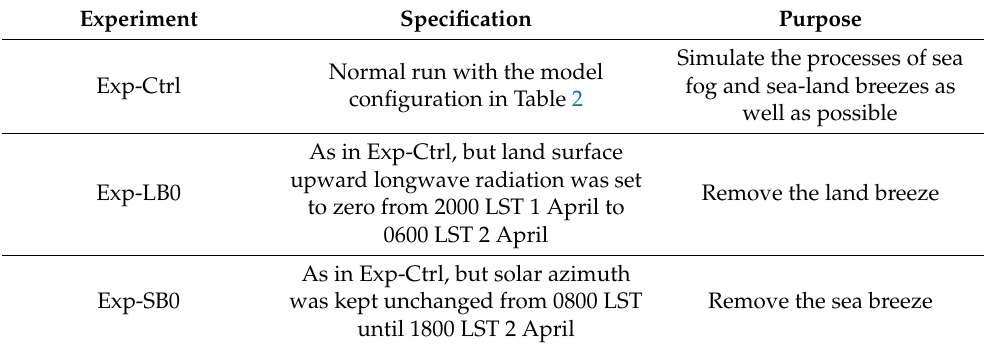
Table 3. List of the numerical